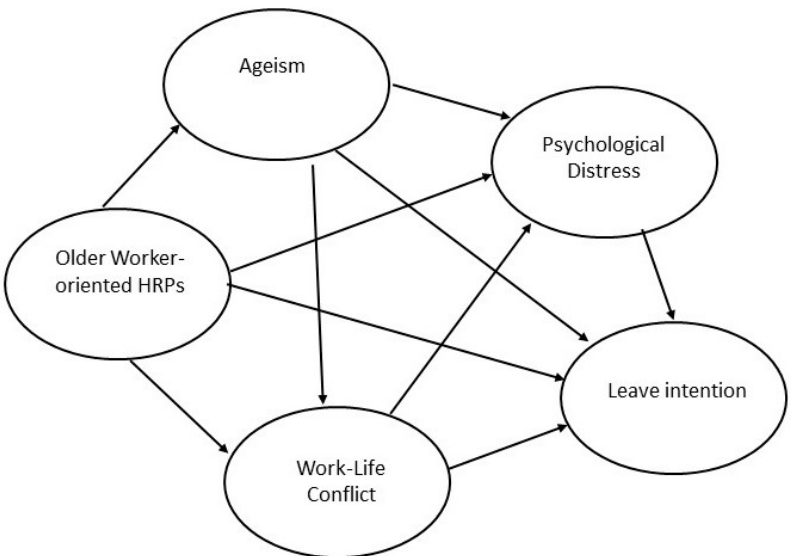
Figure 1. Hypothetical model